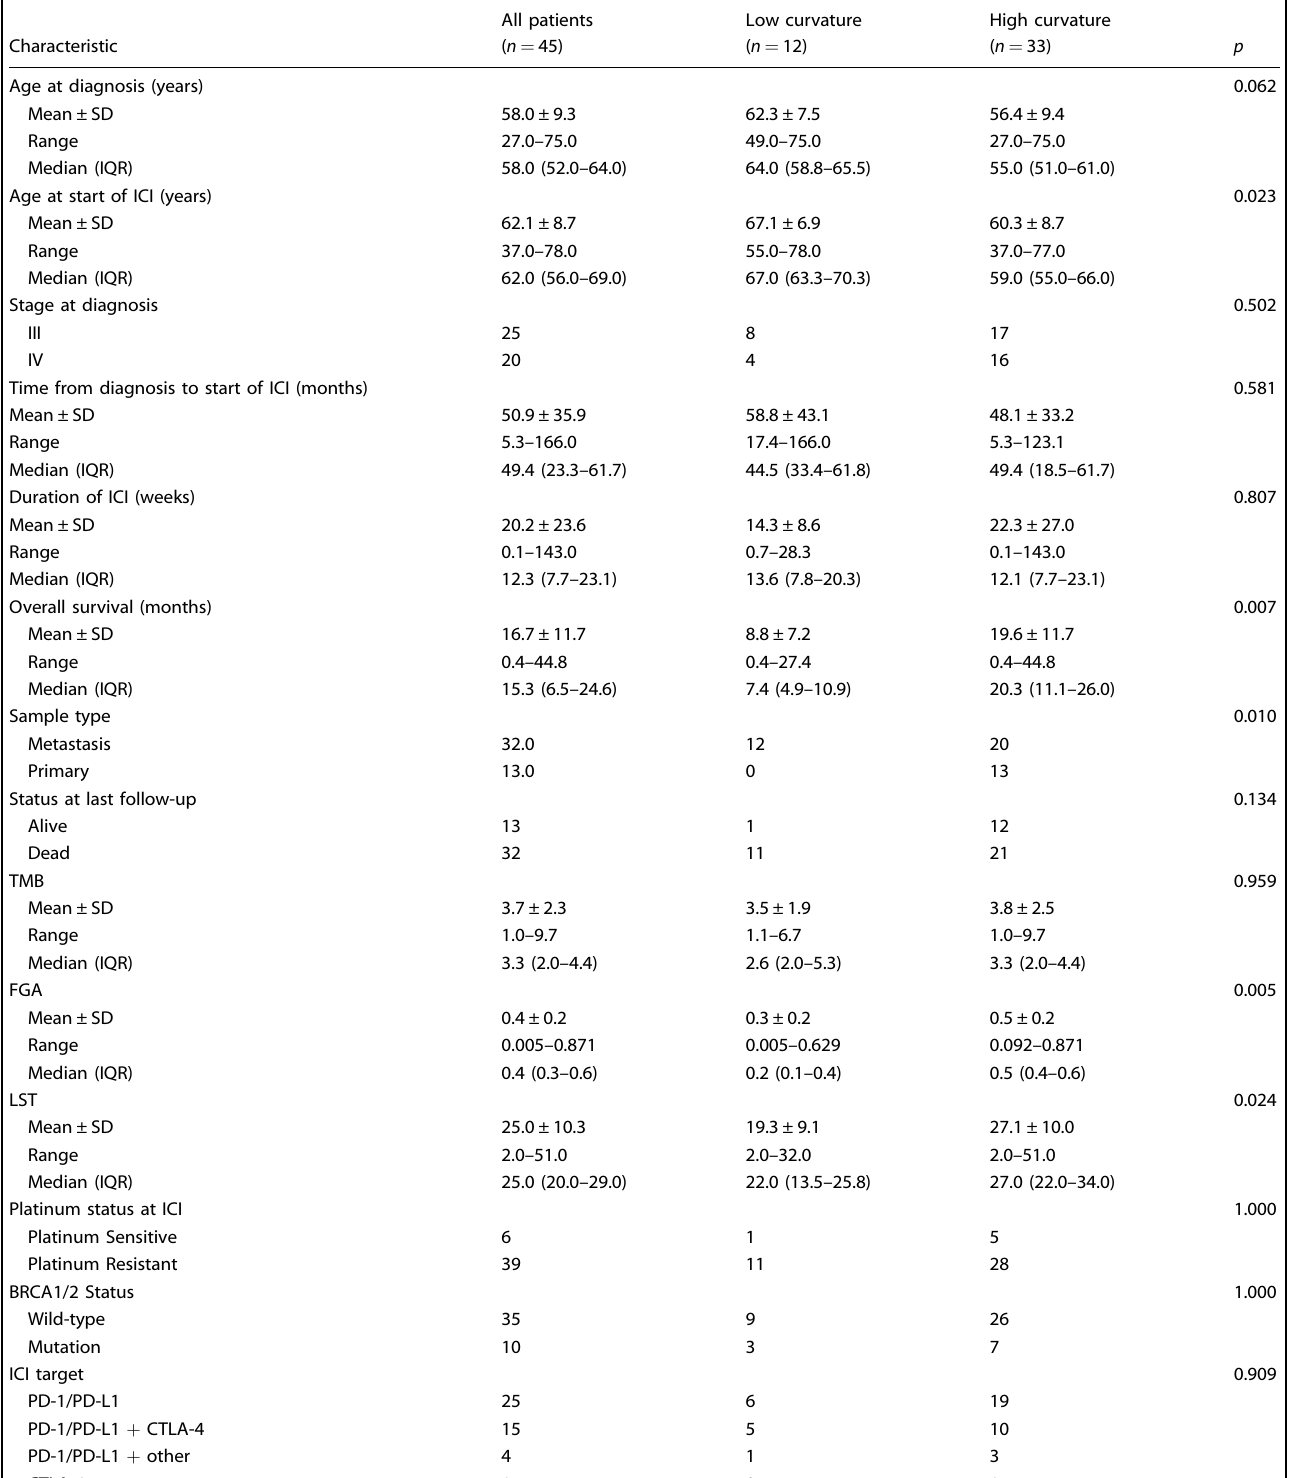
Table 2. HGSOC patient characteristics.